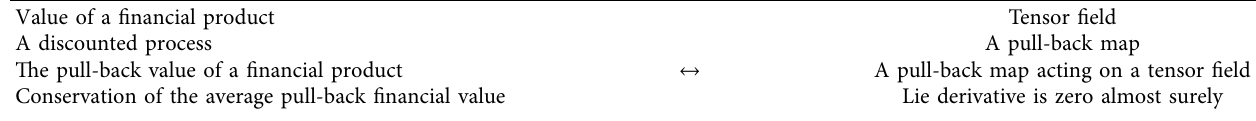
Lie derivative is zero almost surely